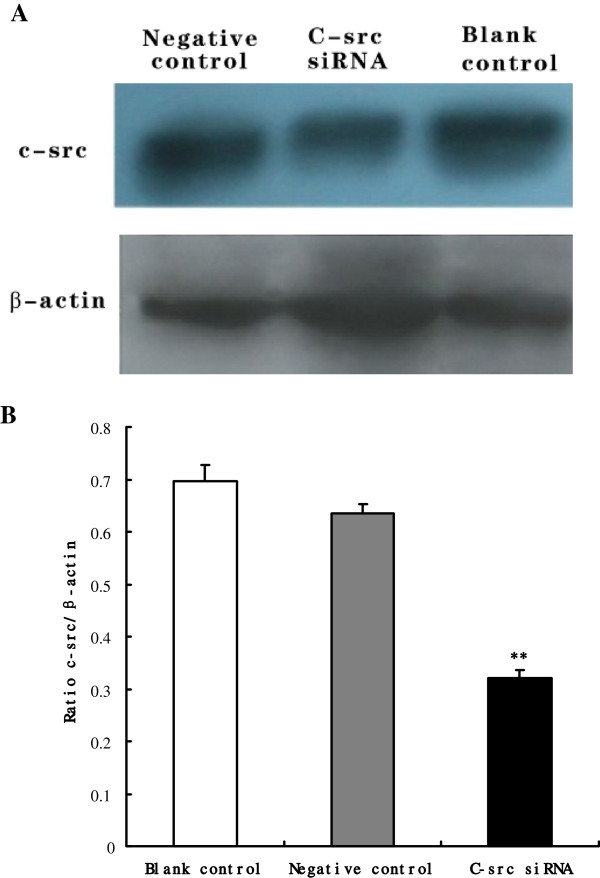
The silencing efficiency of the lentivirus after transfection.A, c-src protein in the ovaries 8 days after lentivirus transfection. B, Semiquantitative results of western blotting from three different replicates. Blank control corresponds to the group with c-src-non-targeting oligonucleotides, negative control corresponds to the group with blank vector (lentivirus without siRNA), and c-src siRNA corresponds to the group with lentivirus packaging c-src siRNA. The data are presented as the means ± SEM (n = 3). **P<0.01 compared with the negative control group.